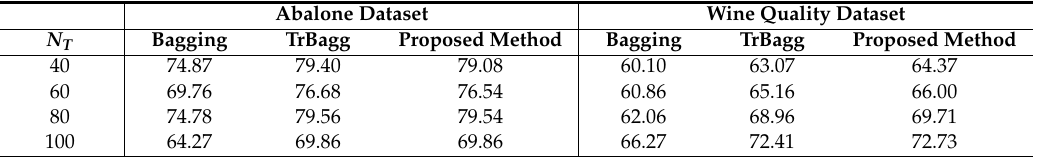
Table 5. Accuracy of test data when α =